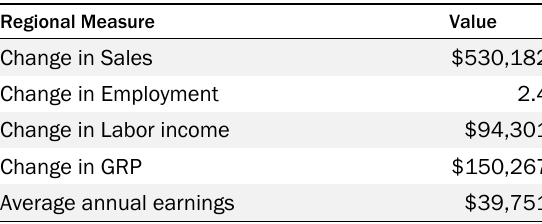
Table 7. Summary of